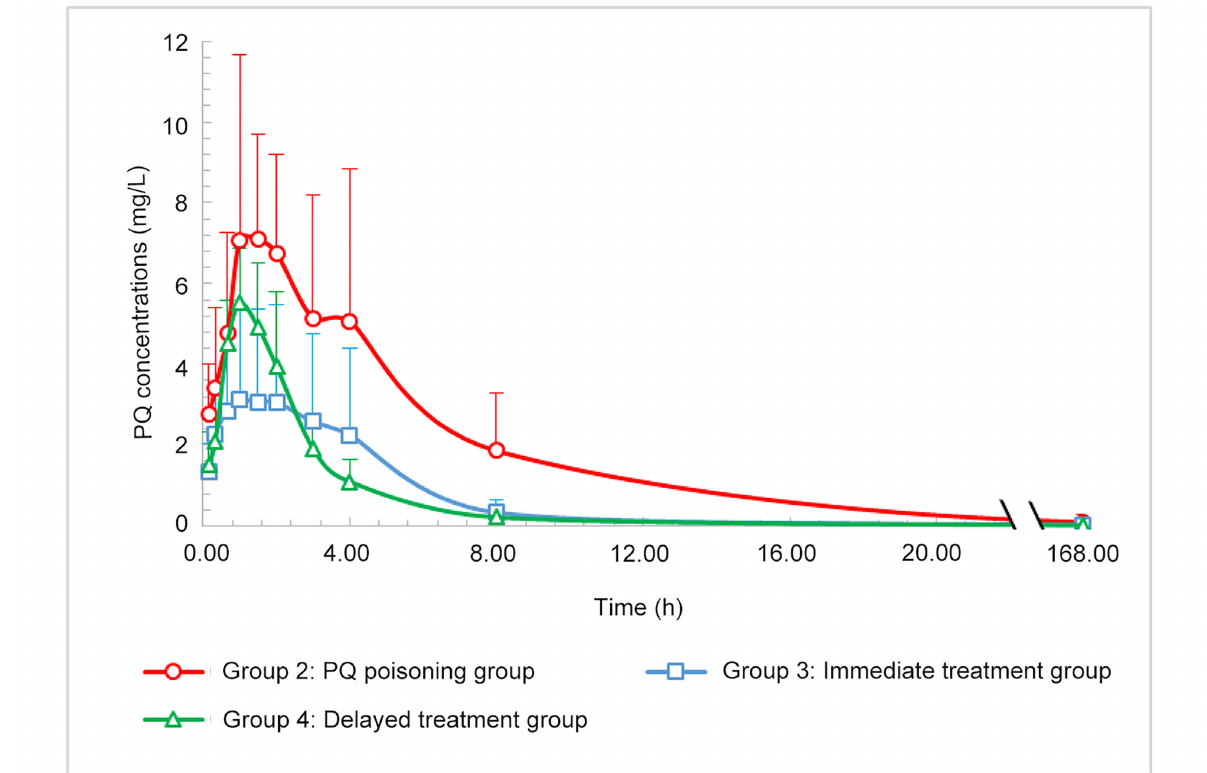
FIGURE 1 - Concentration-time curve of PQ for different